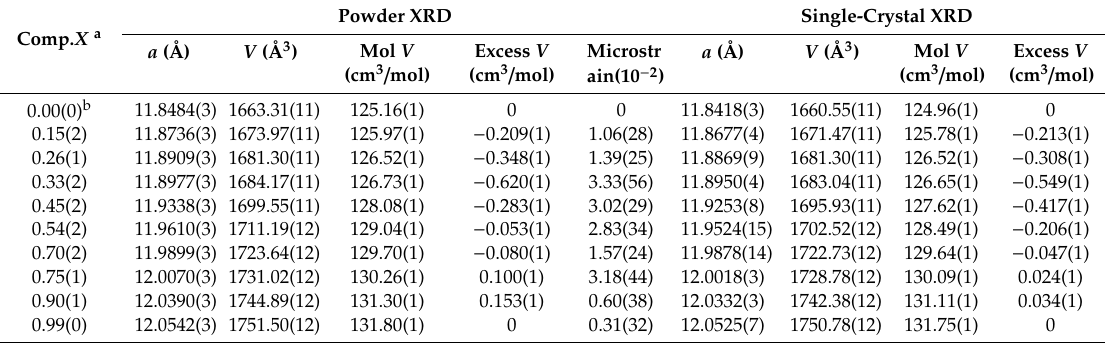
Table 5. The unit-cell size, excess volume, and microstrain of grossular–andradite garnet solid solutions (3 GPa, 1200 ◦ C).